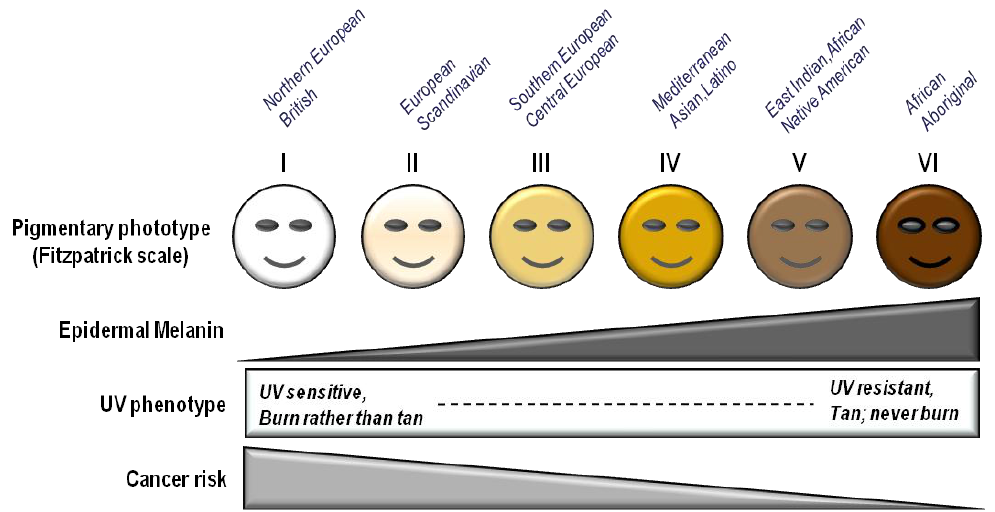
Figure 7. Influence of pigmentation on skin cancer risk. Fair-skinned individuals with low levels of melanin in the epidermis display a UV sensitive phenotype, tending to burn rather than tan, after UV exposure. Recent data suggest that mutations that contribute to fair complexion and tanning impairment, specifically signaling defects in the melanocortin 1 receptor (MC1R), may also be associated with less efficient DNA repair in melanocytes. MC1R-defective individuals not only suffer higher realized doses of UV radiation because their skin is less able to block UV photons, but they may also accumulate more mutations from UV exposure because of defective DNA